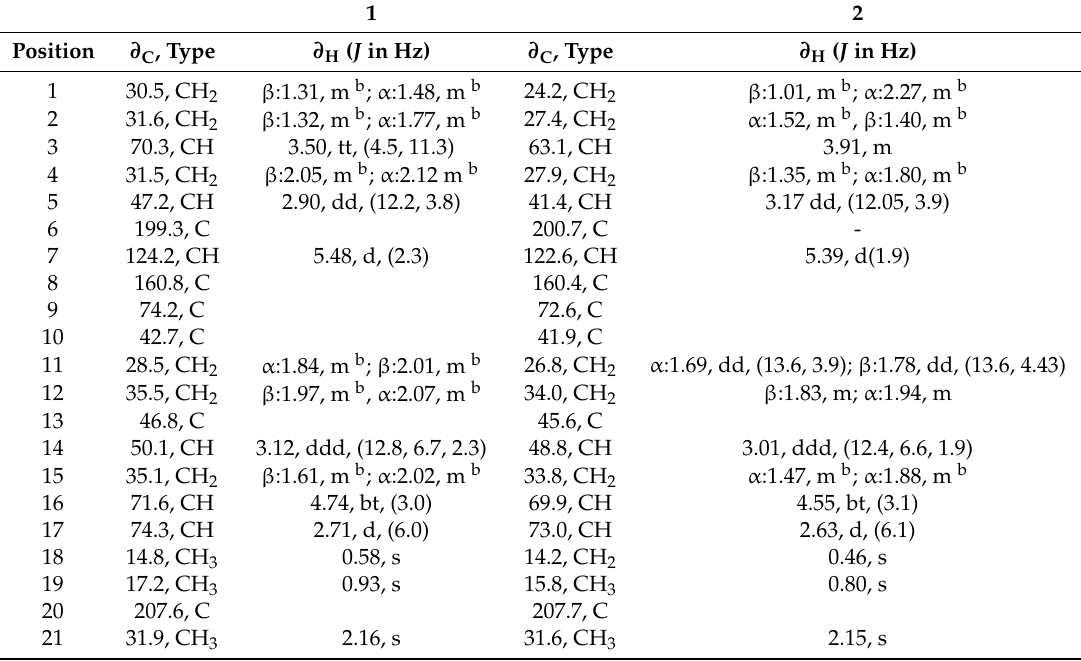
Table 1. NMR data for compounds 1 (in acetone- d 6 ) and 2 (in DMSO- d 6